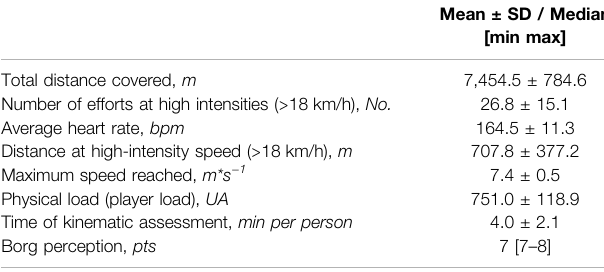
Mean ± SD / Median [min max]